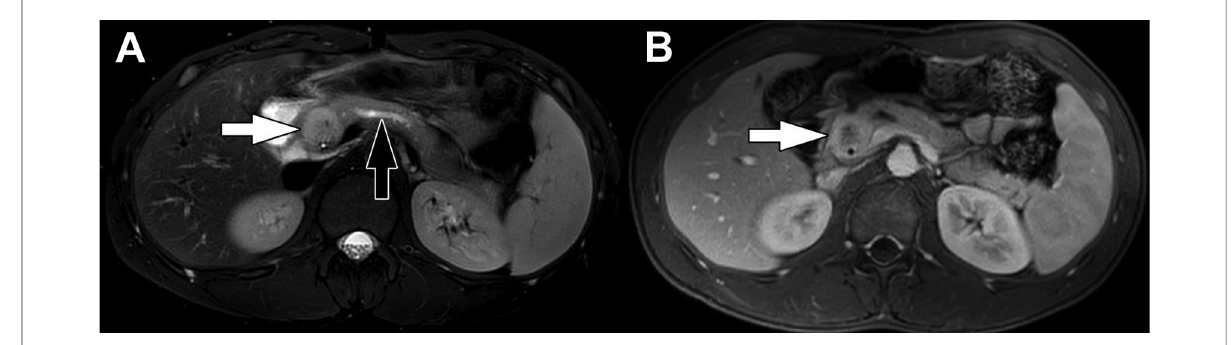
FIGURE 10 In fl ammatory myo fi broblastic tumor. ( A ) Axial T2-weighted fat-saturated MRI and ( B ) Axial T1-weighted fat-saturated post-contrast MRI show a mass in the head of the pancreas (white arrows). The mass is heterogeneously T2-weighted hyperintense with heterogenous enhancement following contrast administration. Lack of central enhancement suggests necrosis. There is associated dilation of the upstream pancreatic duct (black arrow) due to obstruction by the